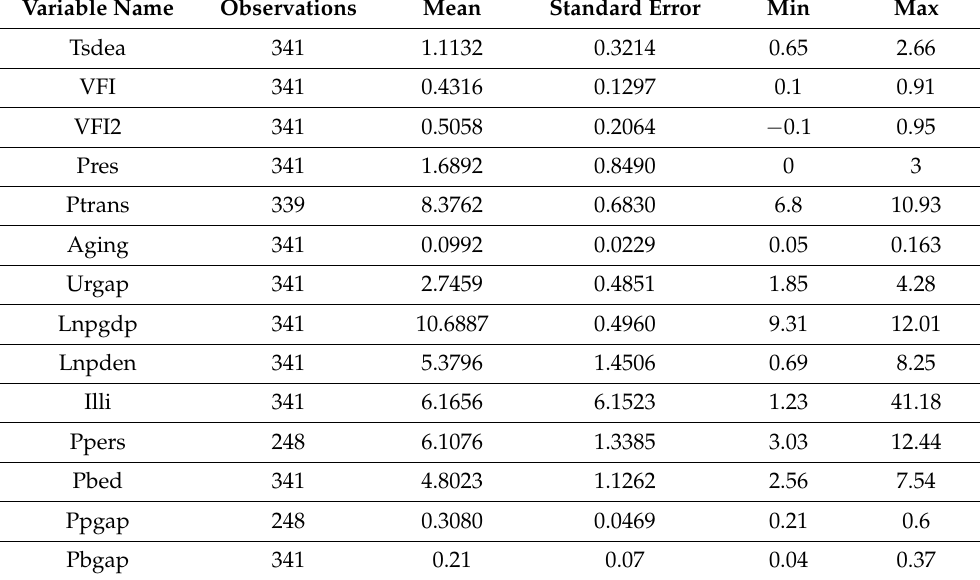
Table 2. Description of statistical characteristics of